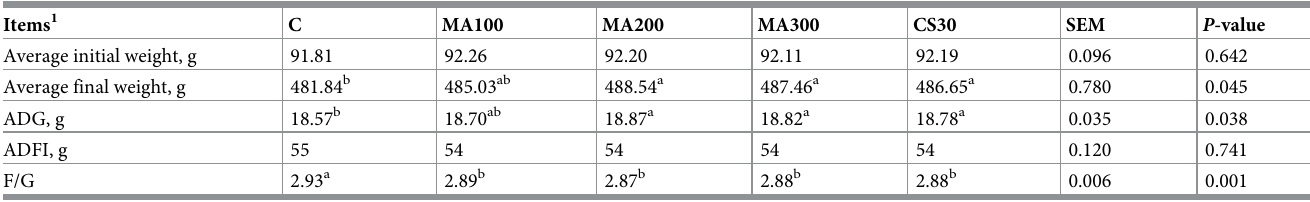
Table 3. Effect of dietary magnolol at different levels on growth performance of Linwu